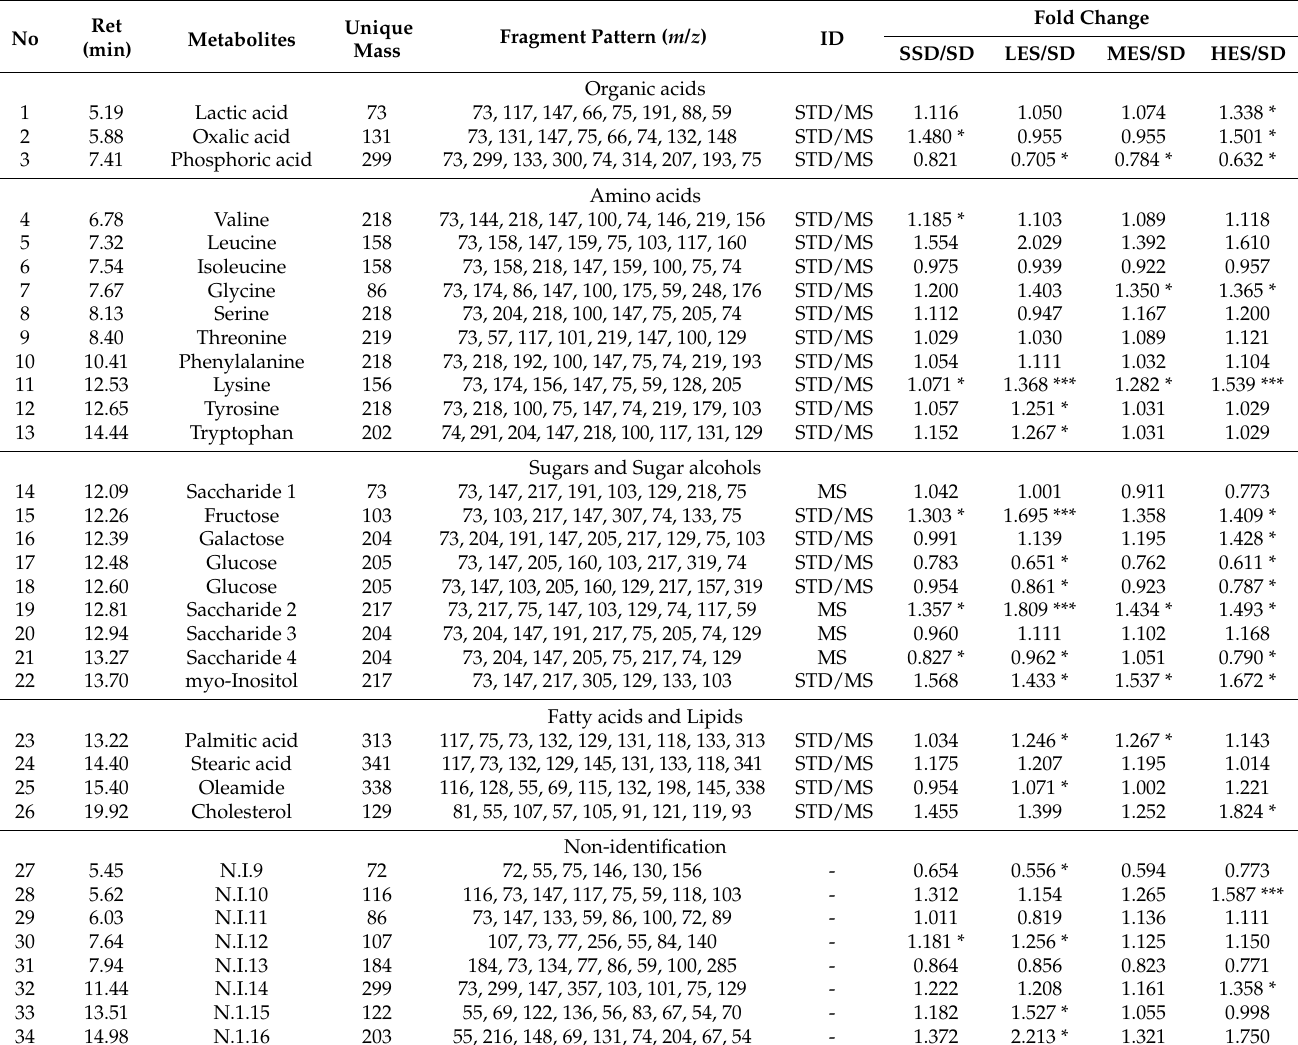
Table 5. List of thirty metabolites altered between SD and